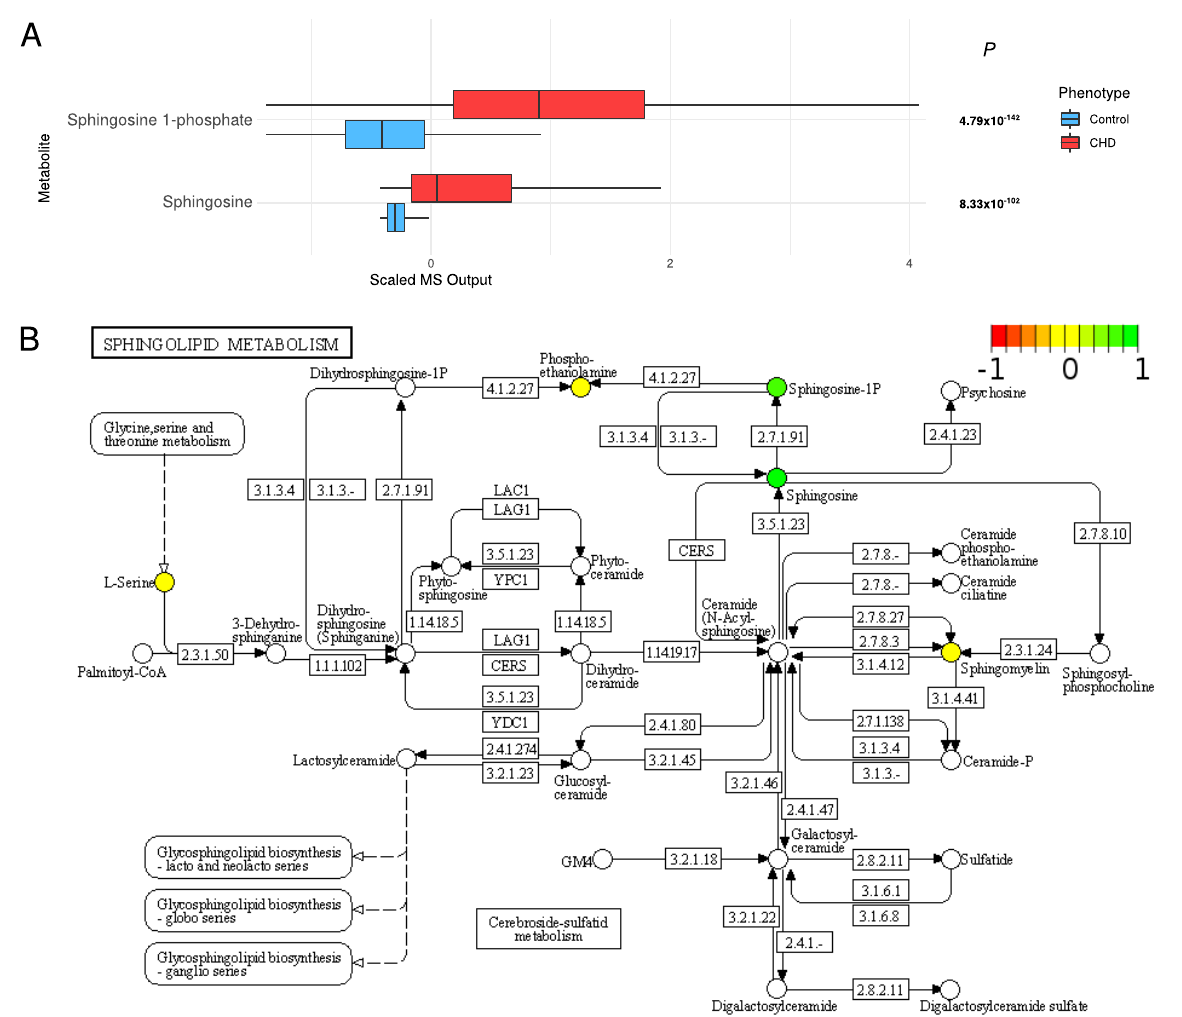
Figure 6. ( A ) The distribution of sphingolipids in the CHD patients and the controls. ( B ) The sphingolipid metabolism pathway (KEGG pathway: hsa00600). Colored metabolites are found in our metabolomic profile. Metabolites in red, yellow, and green have lower, the same, and higher concentrations compared with controls, respectively.